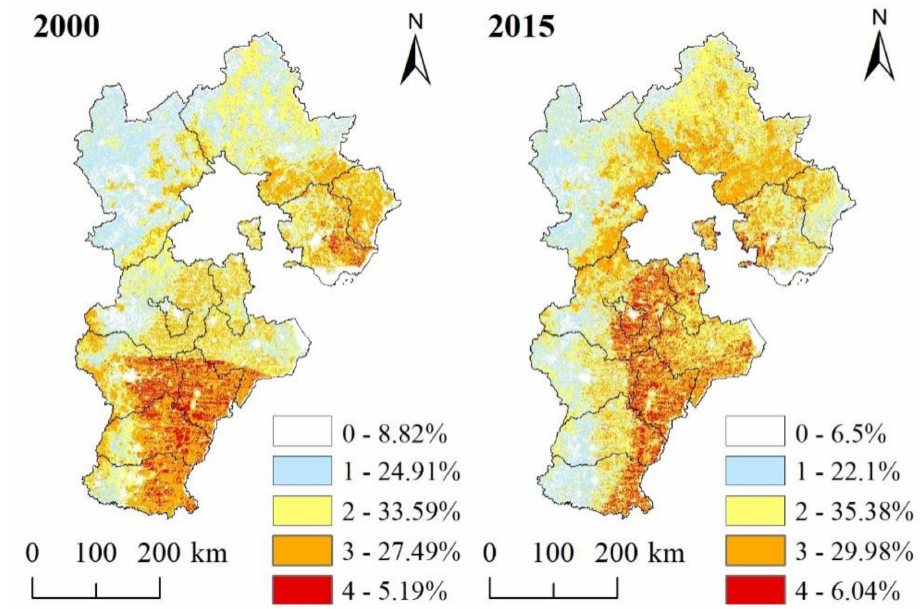
Figure 6. Distribution of the hot spots of multiple ESs in Hebei during